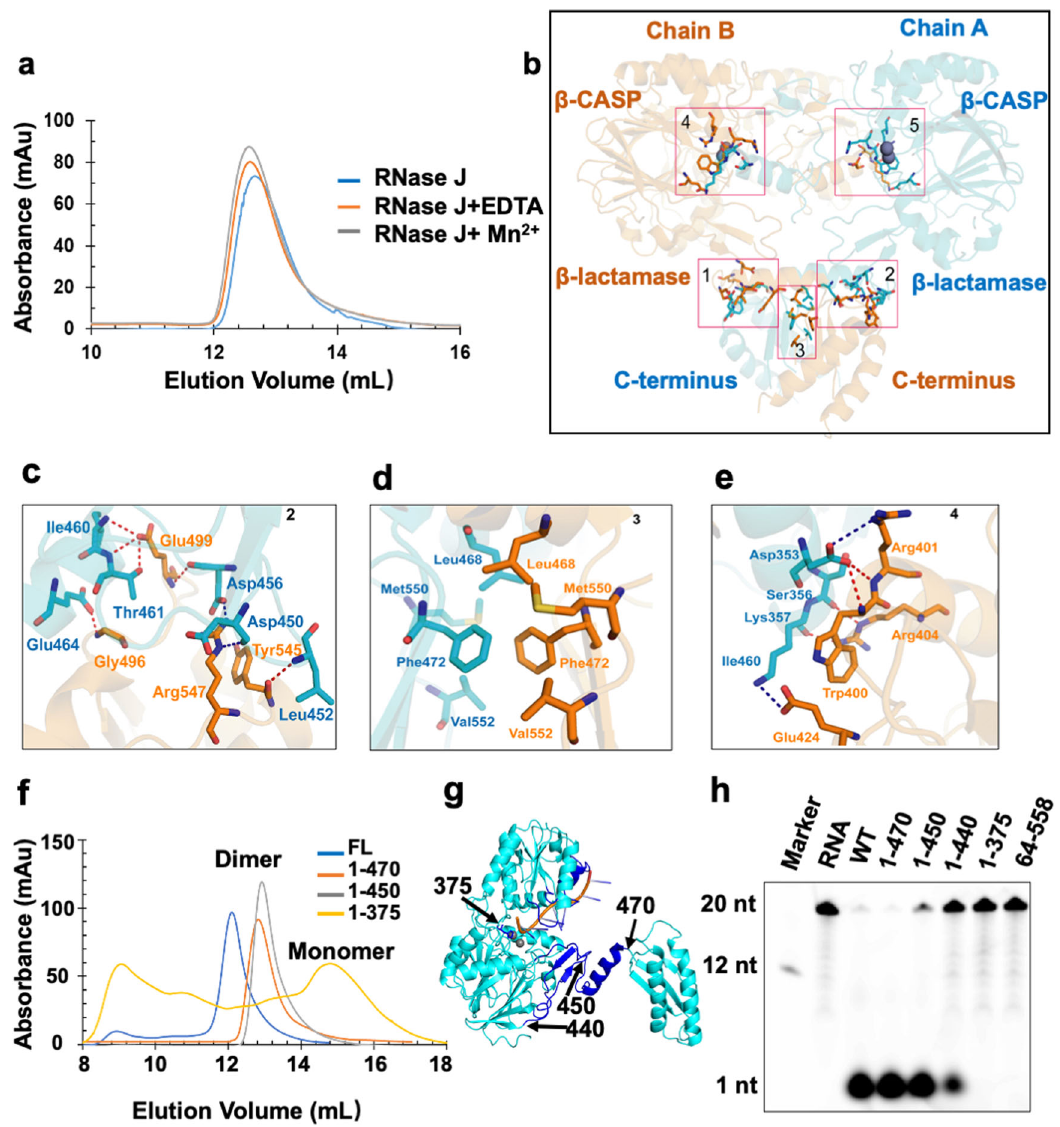
Fig. 5 | The dimeric mechanism of Mtb-RNase J. a Superimposition of the gel fi ltration pro fi les of Mtb-RNase J alone or with 10mM EDTA or Mn 2+ on a Super- dex200 10/300 column. b Overview of the interacting interfaces of the two Mtb- RNase J chains. Chains A and B were colored cyan and orange, respectively. The detailed residues were shown in the sticks. c – e Enlarged view of the interacting